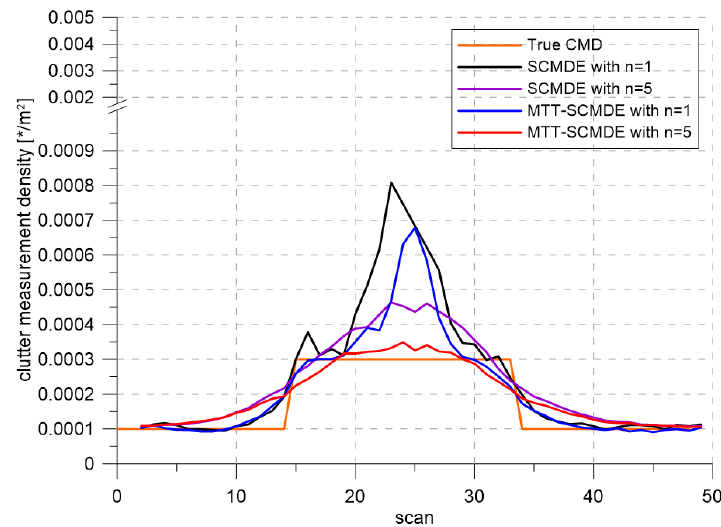
Figure 6. True clutter measurement density and estimated clutter measurement density.